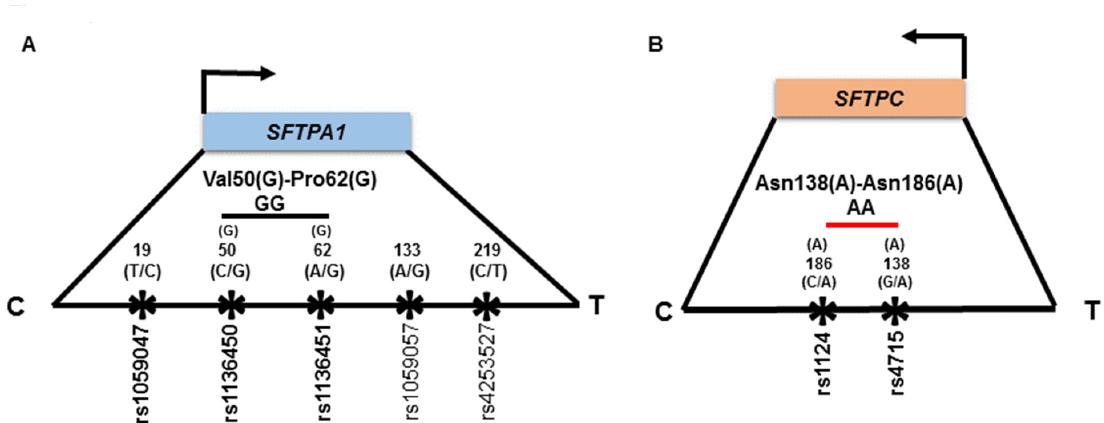
Figure 2. ( A ) shows schematic presentation of SFTPA1 and ( B ) shows SFTPC gene and transmission of haplotypes in ARF. The relative location of genes is shown from centromere ( C ) to telomere (T). In each panel, the number above the solid black line indicates the amino acid number and corresponding nucleotide change shown in parenthesis. The SNP id is shown below the black line. The arrows indicate transcriptional orientation. The transmitted haplotypes and corresponding amino acid changes are shown in bold in a two-SNP model. A shows the location of the SFTPA1 gene in blue on the long arm of chromosome 10. Haplotype “GG” shown in black line, constituted by rs1136450 Val(G) at codon 50 and rs1136451 Pro(G) at codon 62 within the SFTPA1 gene, are associated with increased ARF risk in a previously healthy children, p = 0.02, OR = 9.3 (1.7–49.6). B shows the SFTPC gene in orange and its orientation in terms of the centromere and telomere. The haplotype “AA”, shown in red line, constituted by rs4715 Asn(A) at codon 138 and rs1124 Asn(A) at codon 186 within the SFTPC gene, is shown to associate with lower risk for ARF, p = 0.02, OR = 0.4 (0.2–0.7). Both significant haplotypes have a dominant effect on ARF. Of note, the physical location of the transmitted SNPs in these haplotypes is very close, as shown in Figure.